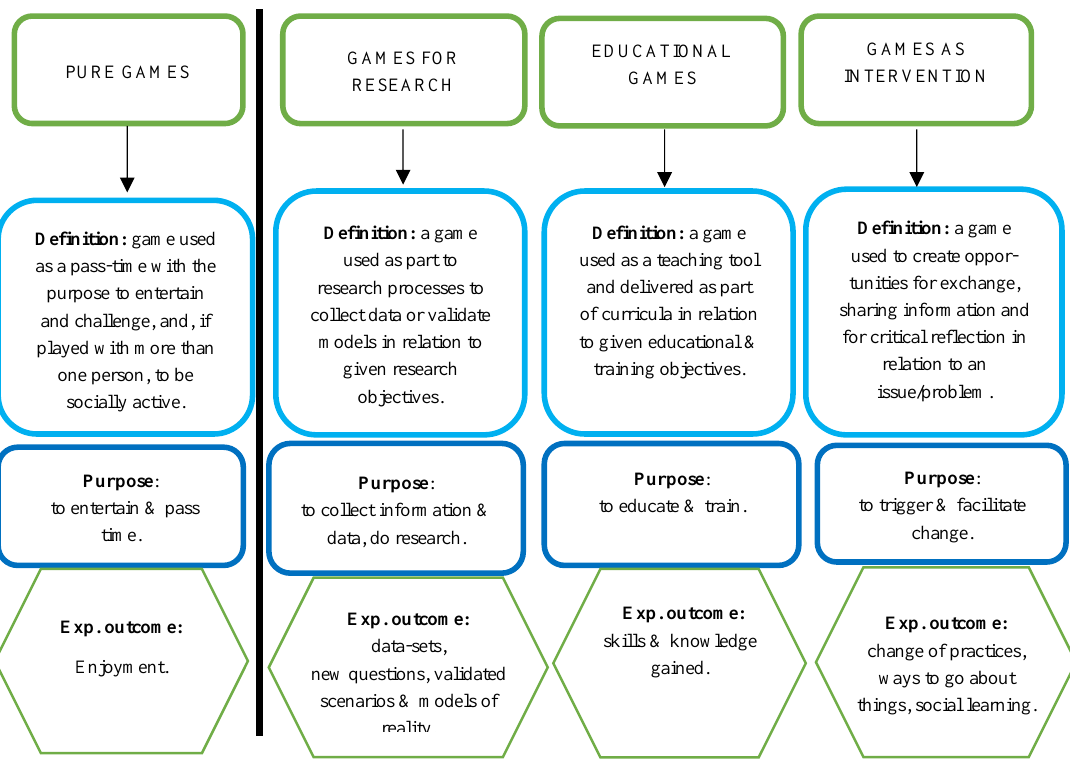
Figure 1. Differences in the use of serious games in natural resource and environmental governance.